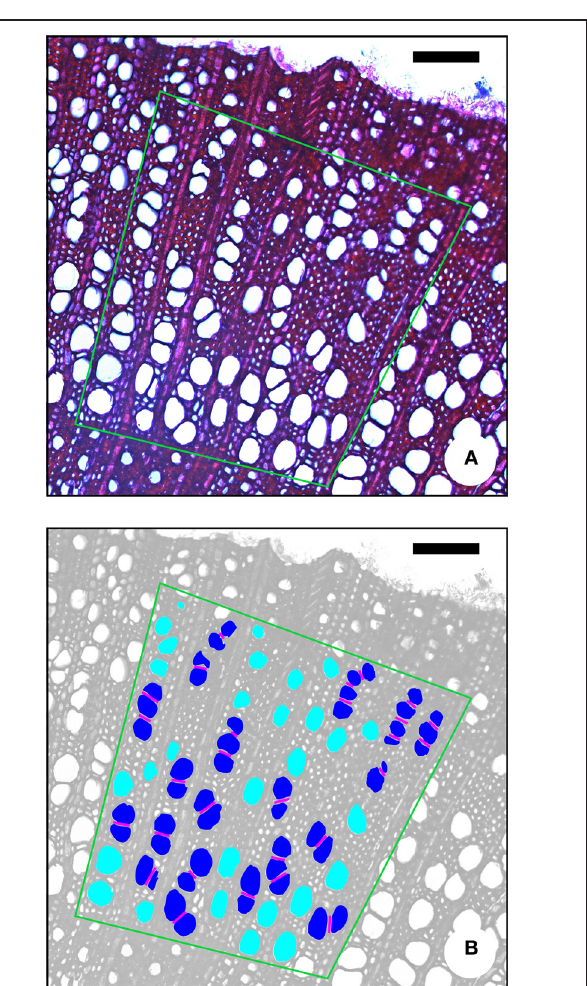
FIGURE 1 | Illustration of some characters that can be measured on a transverse section of Prunus domestica . (A) The original image, (B) the same image modified for image-analysis. Diameter (D) and perimeter (P) are easily measured on transverse sections. For calculating the vessel grouping index ( V G ), the number of vessel groups and the total number of vessels has to be determined. Light blue, solitary vessels (one vessel per group); dark blue, vessel multiples (two or more vessels per group). Pink lines, (inter) vessel contact length ( L VW ). Green polygon, AOI (area of interest), covering earlywood and latewood. All vessels outside the AOI were excluded. Scale bar = 100 μ